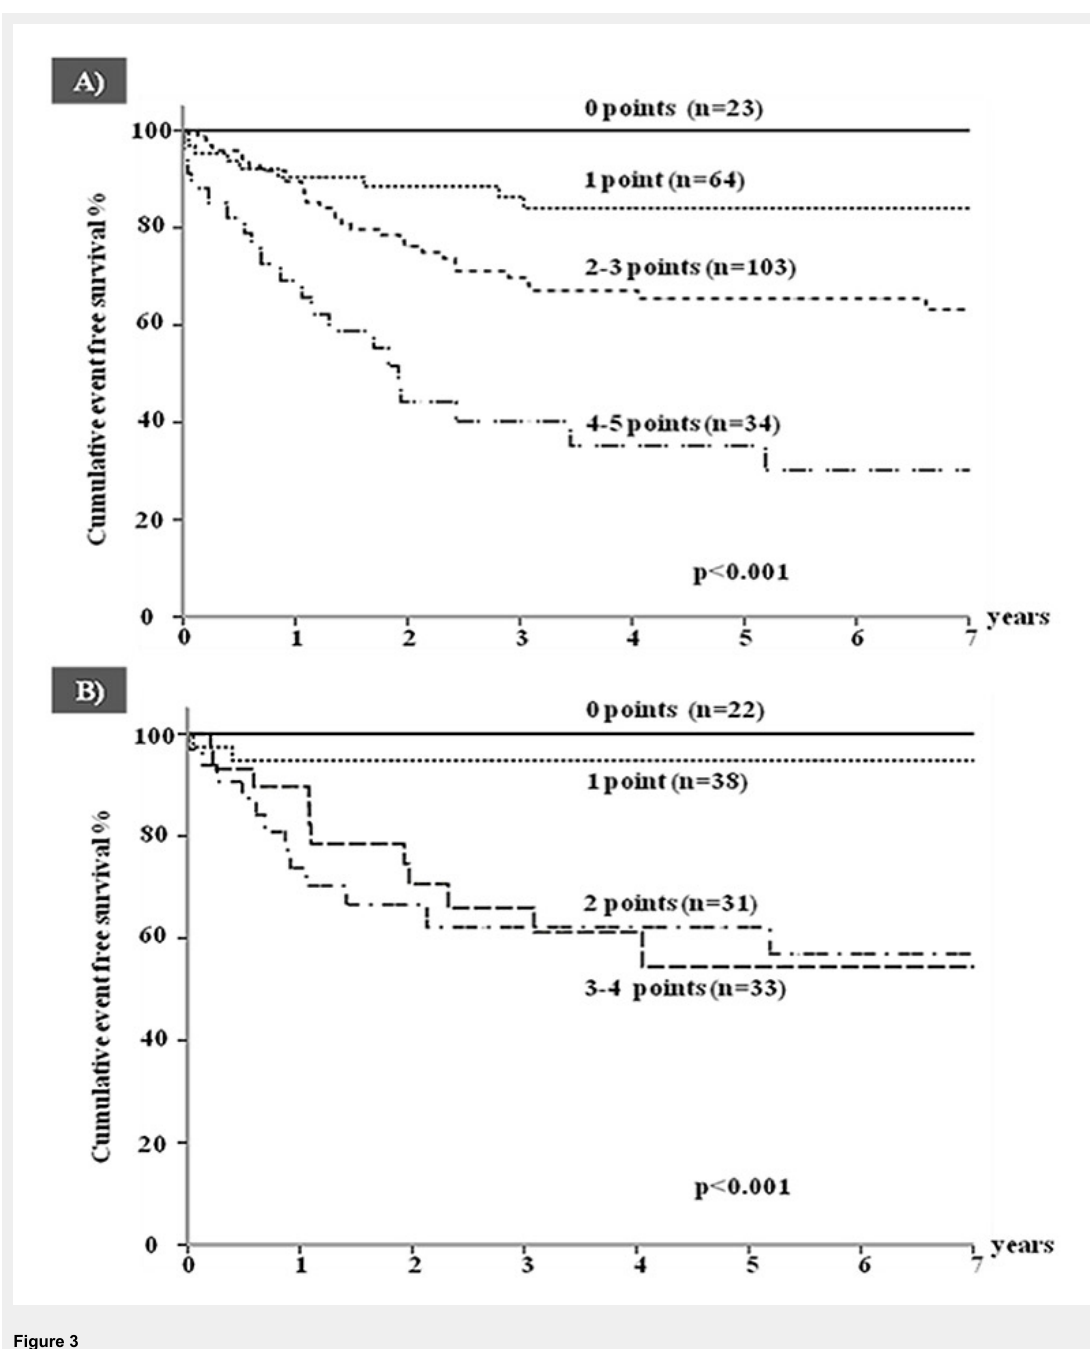
Cumulative event-free survival for a first appropriate implantable cardioverter defibrillator shock according to increasing risk score (M-FACT) in (A) all patients and (B) in patients with no prior aborted cardiac arrest. (Reproduced from reference